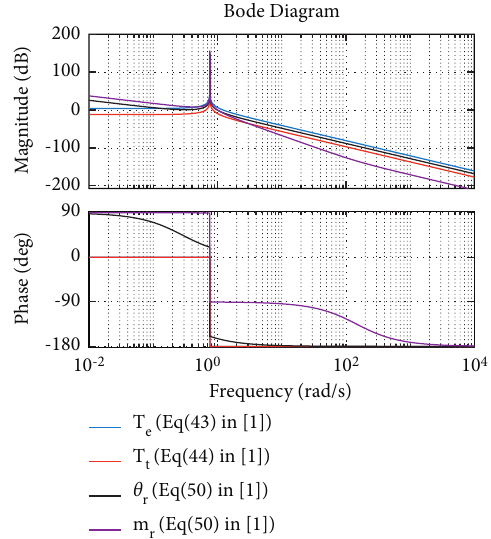
Figure 4: Bode characteristics of the input variables.